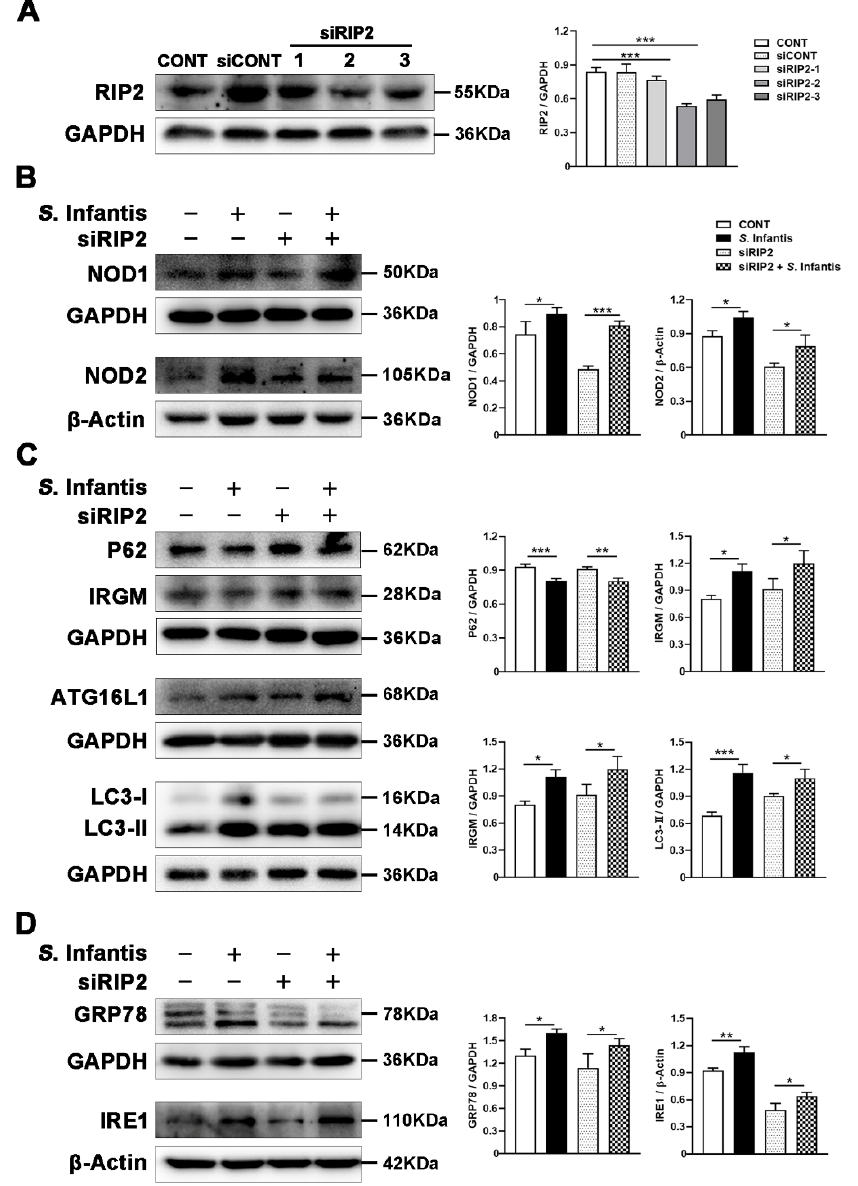
Figure 6. Silencing RIP2 could not block S . Infantis-induced autophagy and ER stress in Caco2 cells. ( A ) Western blotting analysis in Caco2 cells treated with siRNA-targeting RIP2. ( B , C , and D ) Western blotting analysis for NOD1, NOD2, P62, IRGM, ATG16L1, LC3, GRP78, and IRE1 in Caco2 cells. The right panels show the protein quantitation using Image J software. Data are represented as mean ± SEM, n = 3; * p < 0.05, ** p < 0.01, *** p < 0.001.